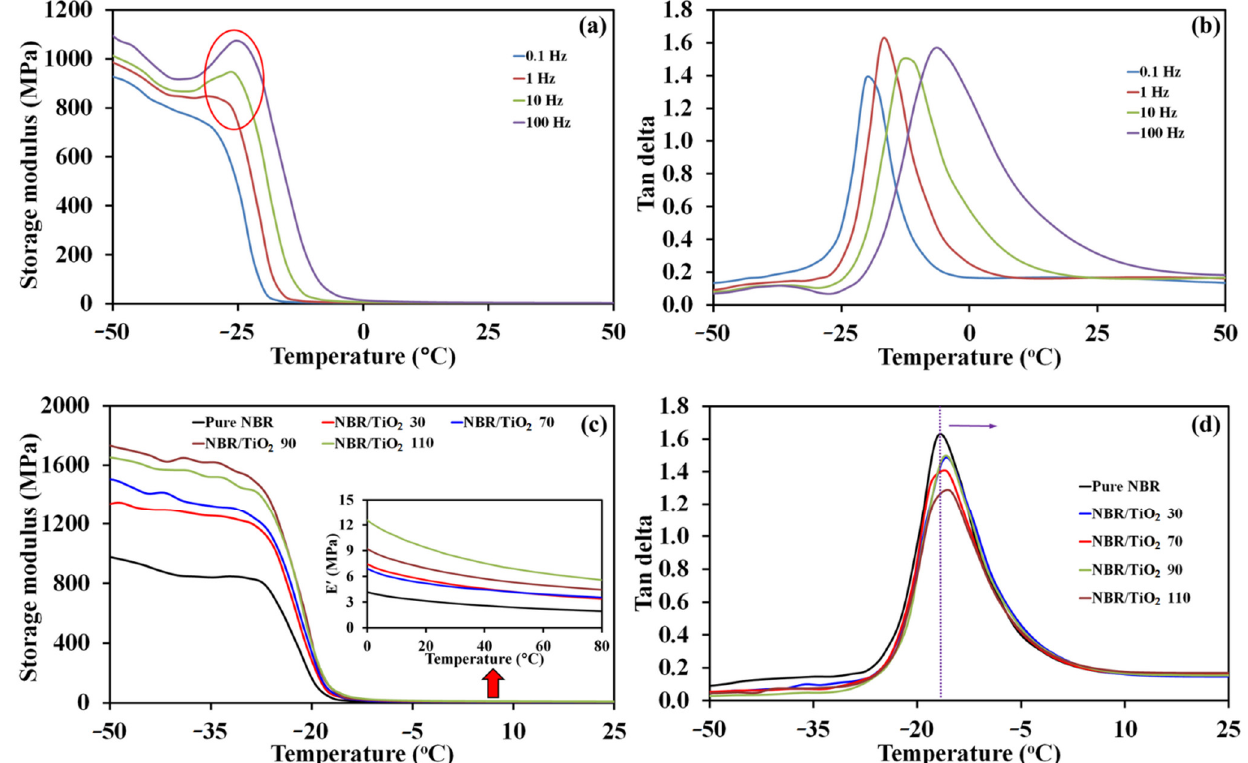
Figure 5. ( a ) Storage modulus, and ( b ) tan δ as functions of temperature for pure NBR at several frequencies; ( c ) storage modulus, and ( d ) tan δ as functions of temperature for TiO 2 -filled NBR composites with various TiO 2 loadings at 1 Hz.